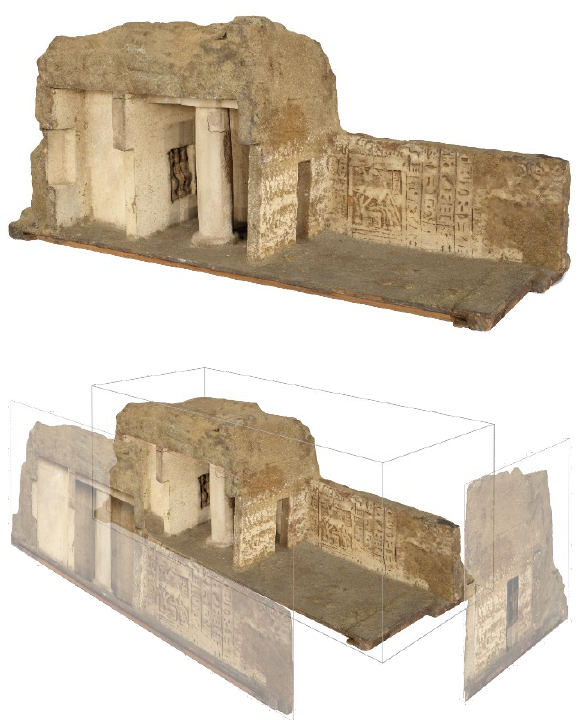
Figure 8. Above: Beit el Wali, digital relief of the model (dimensions of the two halves 51 x 68 x 29 cm). Below: Construction of the images by projection on the bounding box.